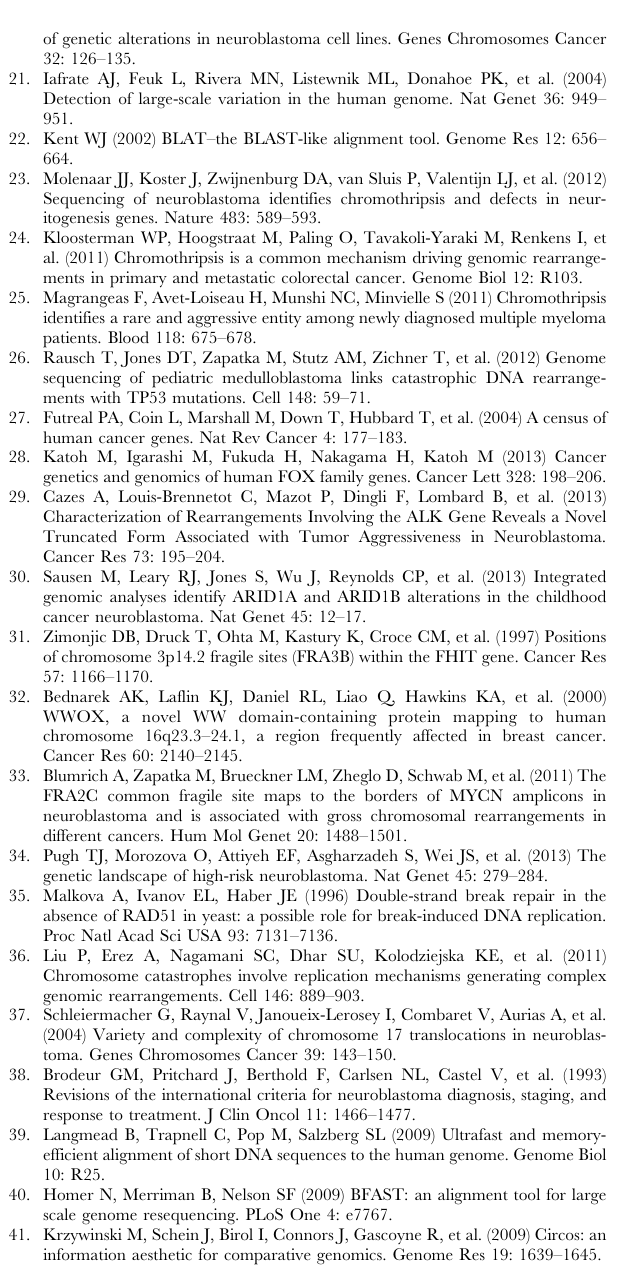
Table S6 Statistically significant enrichment of motifs at rearrangement